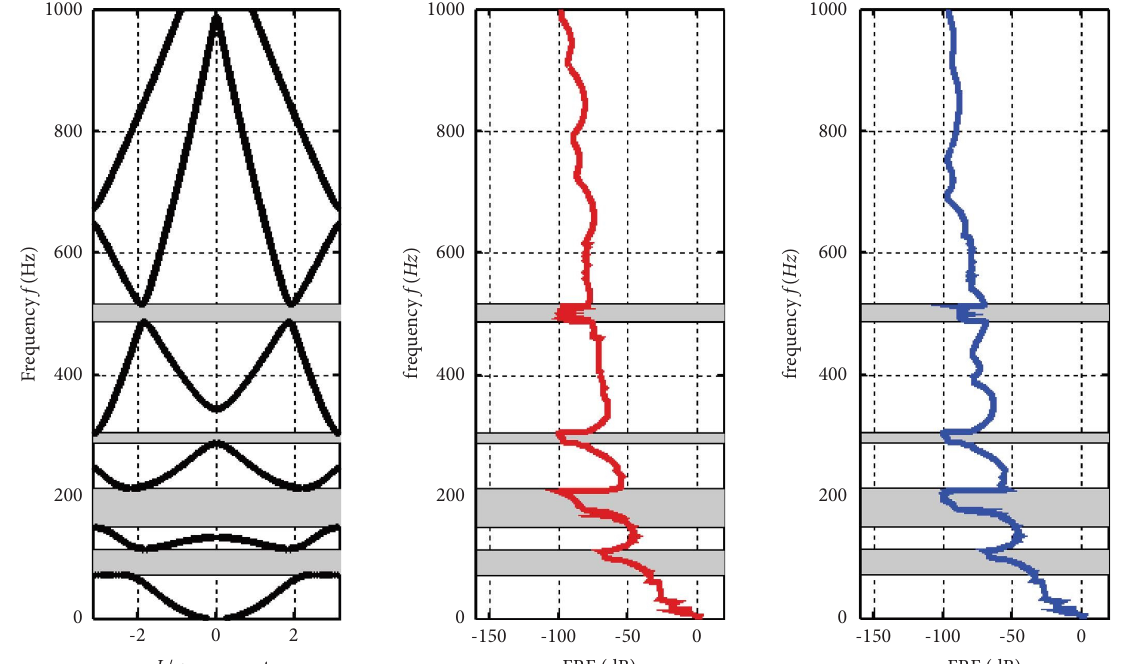
Figure 14: Comparison between the theoretical bandgaps and FRFs of the double-beam